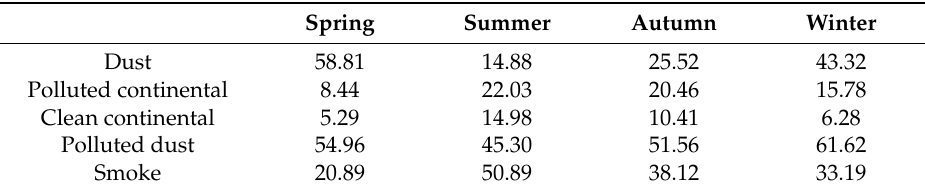
Figure 3. Distribution of dominant aerosols with a spatial resolution of one degree over central China in each season from March 2007 to February 2016. Table 1. Statistics of the regional average occurrence frequency of each different aerosol subtype over central China for each season from March 2007 to February 2016 (unit: %).